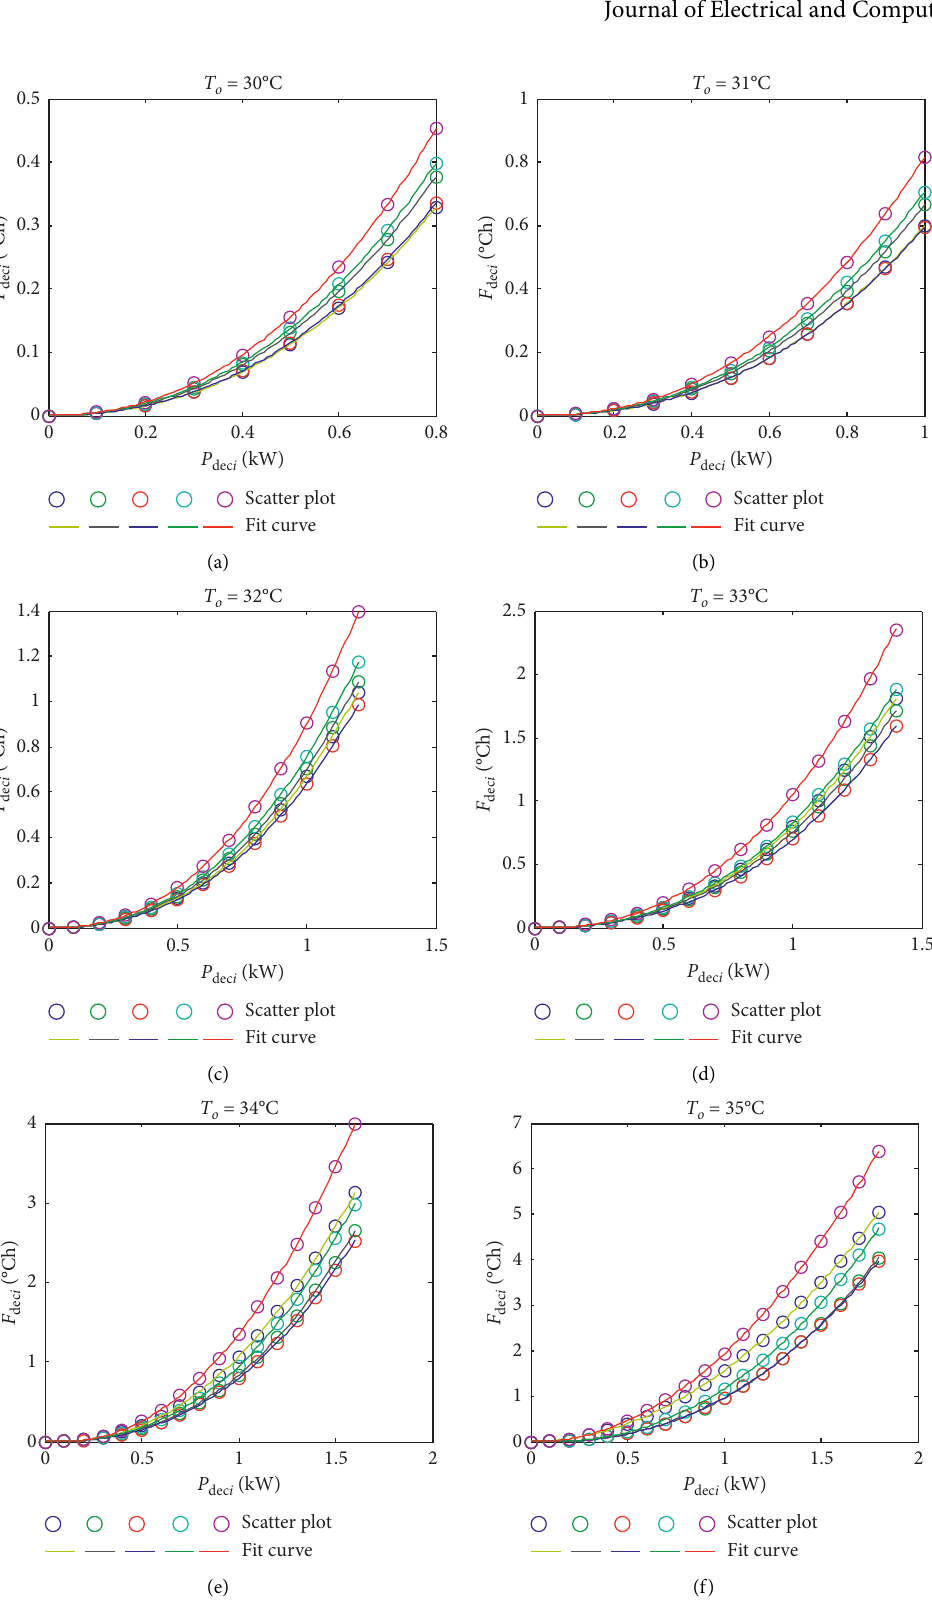
Figure 7: Scatter plot and fit curve of P dec - F dec with different outer